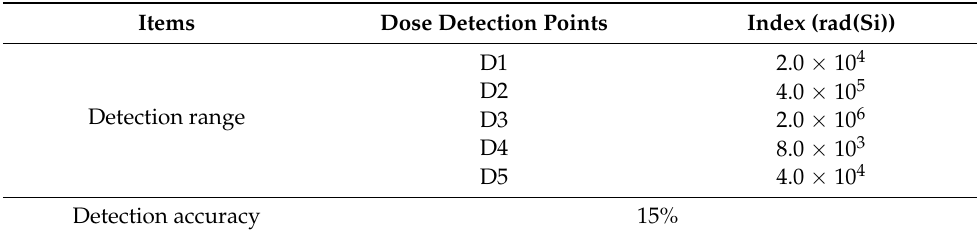
Table 1. The main technical indexes of the radiation dose detector.